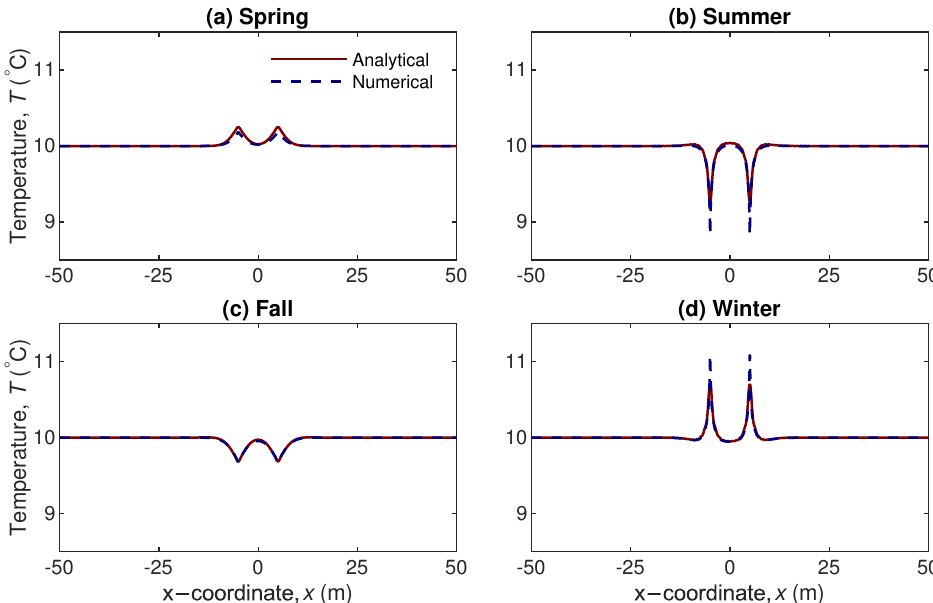
Figure 6. Temperature distribution over the x -coordinate (i.e., the line y = 0) for double boreholes over four seasons: ( a ) Spring ( t = 3 (mon)); ( b ) Summer ( t = 6 (mon)); ( c ) Fall ( t = 9 (mon)); and ( d ) Winter ( t = 12 (mon)). The analytical solution is given by the red solid line and the numerical solution is given by the blue dashed line.